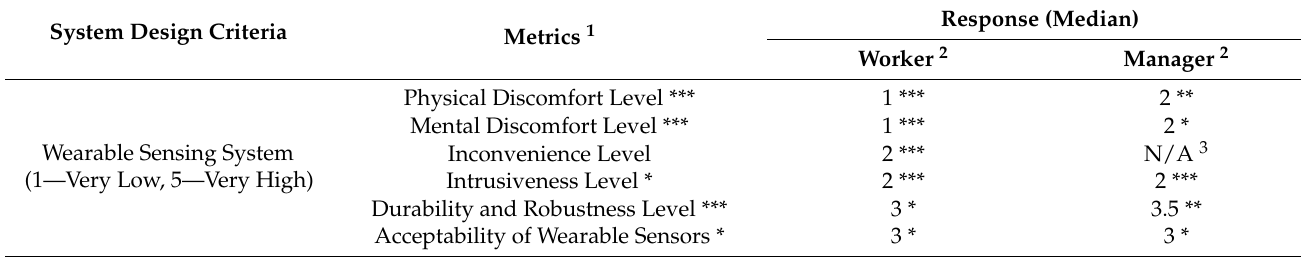
Table 5. Evaluation of wearable sensors.